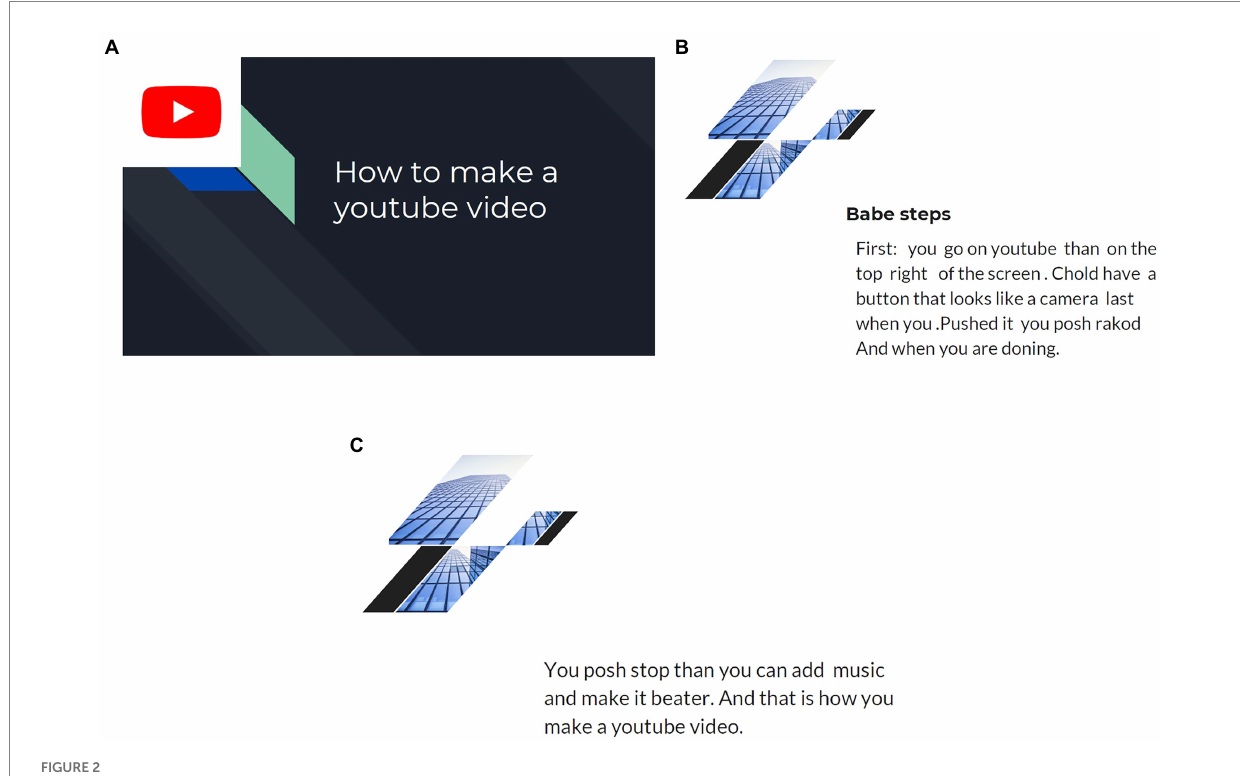
FIGURE 2 (A-C) Larry’s Google Slides walk-through on “How to Make a YouTube